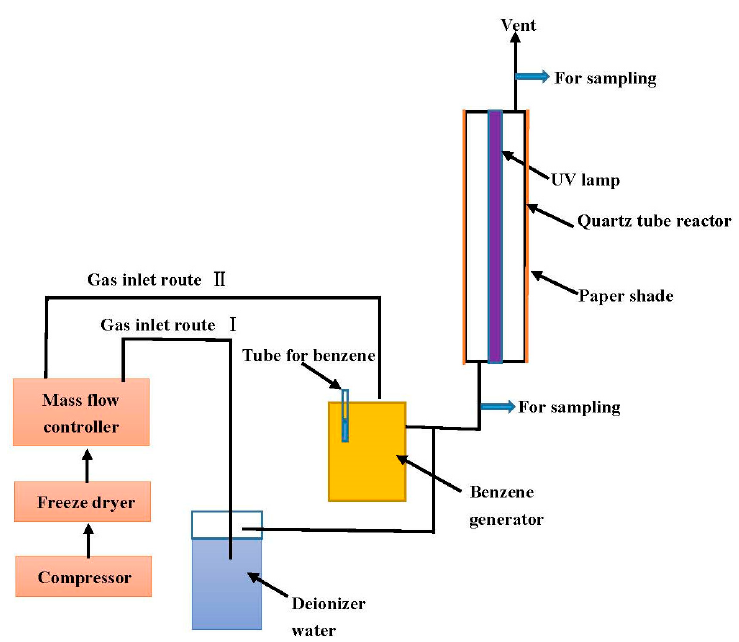
Figure 5. The flow sheet of the tubular photoreactor used in the photodegradation experiments.